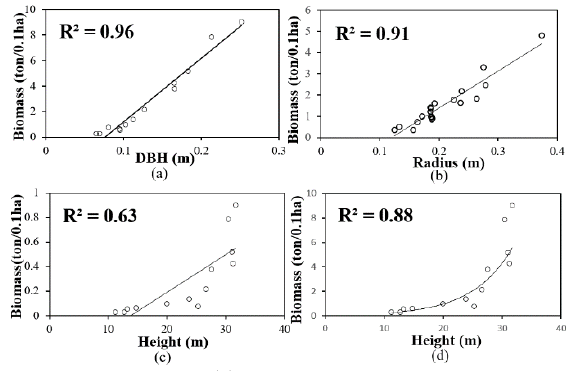
Figure 5 : Represents (a) Correlation between DBH and field estimated biomass (b) Correlation between radius and biomass (c) Correlation between height and biomass (d) Log- transformed correlation between height and